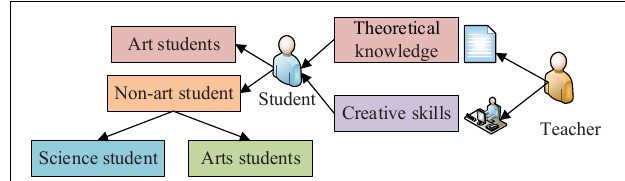
FIGURE 2 | Student sources and teaching methods of Cinematography Major.